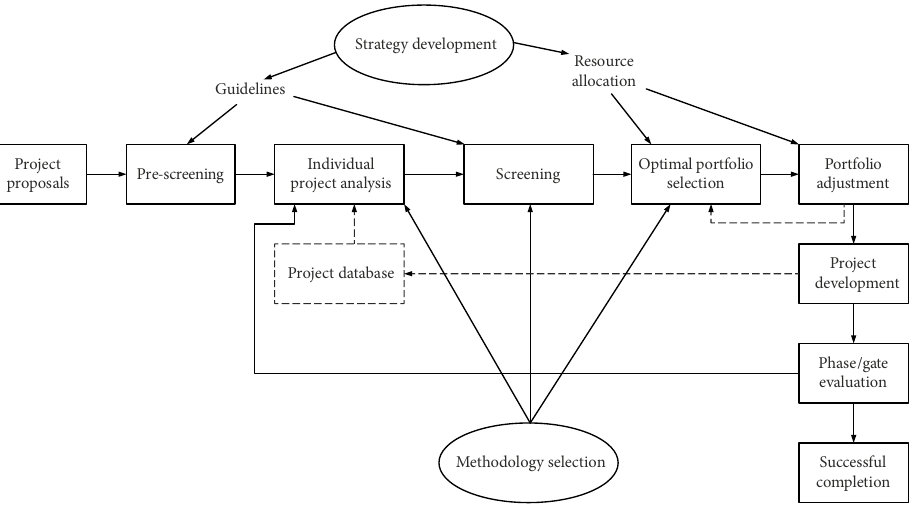
Figure 1. Project portfolio selection framework (Archer & Ghasemzadeh,